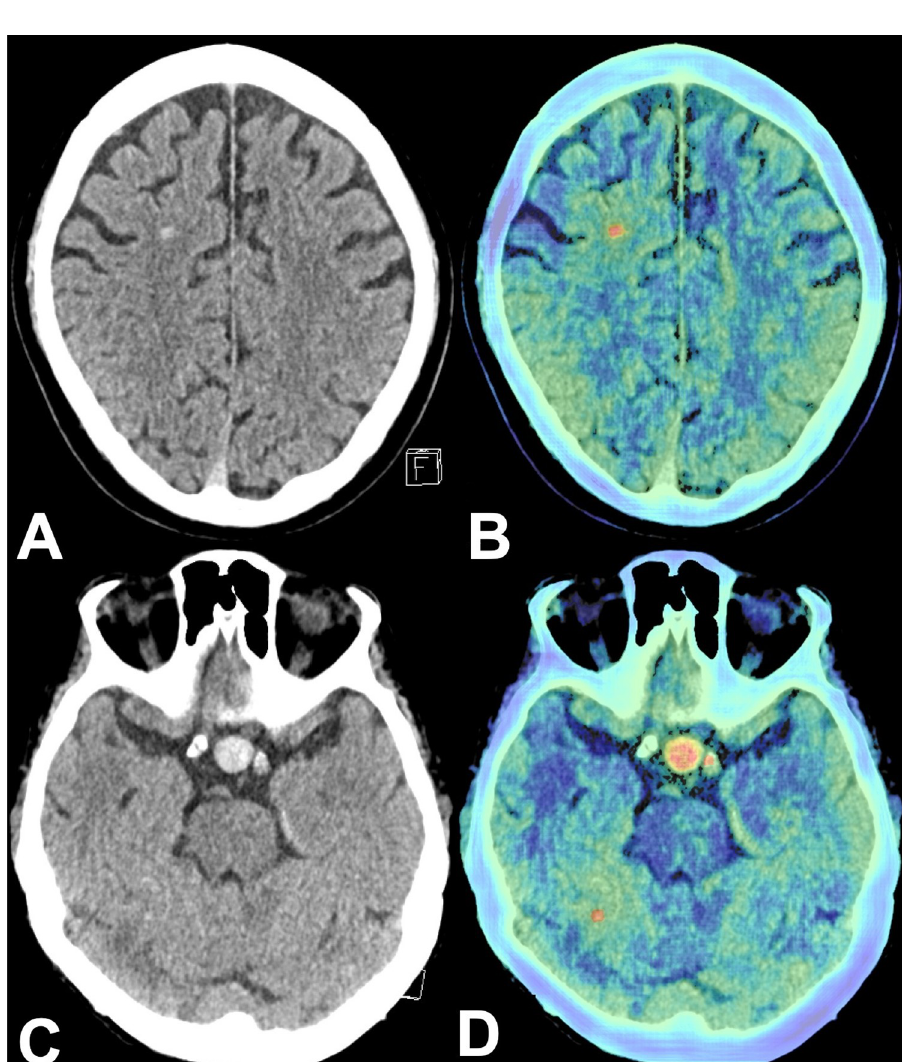
Fig 4. Atypical and pathological blood vessels. A: Axial HCT with hyperdense appearance of a DVA of the right frontal lobe. B: Corresponding color-coded map flagging the DVA. C: Axial HCT showing an aneurysm of the left ICA. D: Color-coded map flagging the ICA aneurysm, the left ICA, and a hyperdense spot of the right cerebellar hemisphere (HCT, head computed tomography; DVA, developmental anomaly; ICA, internal carotid artery).